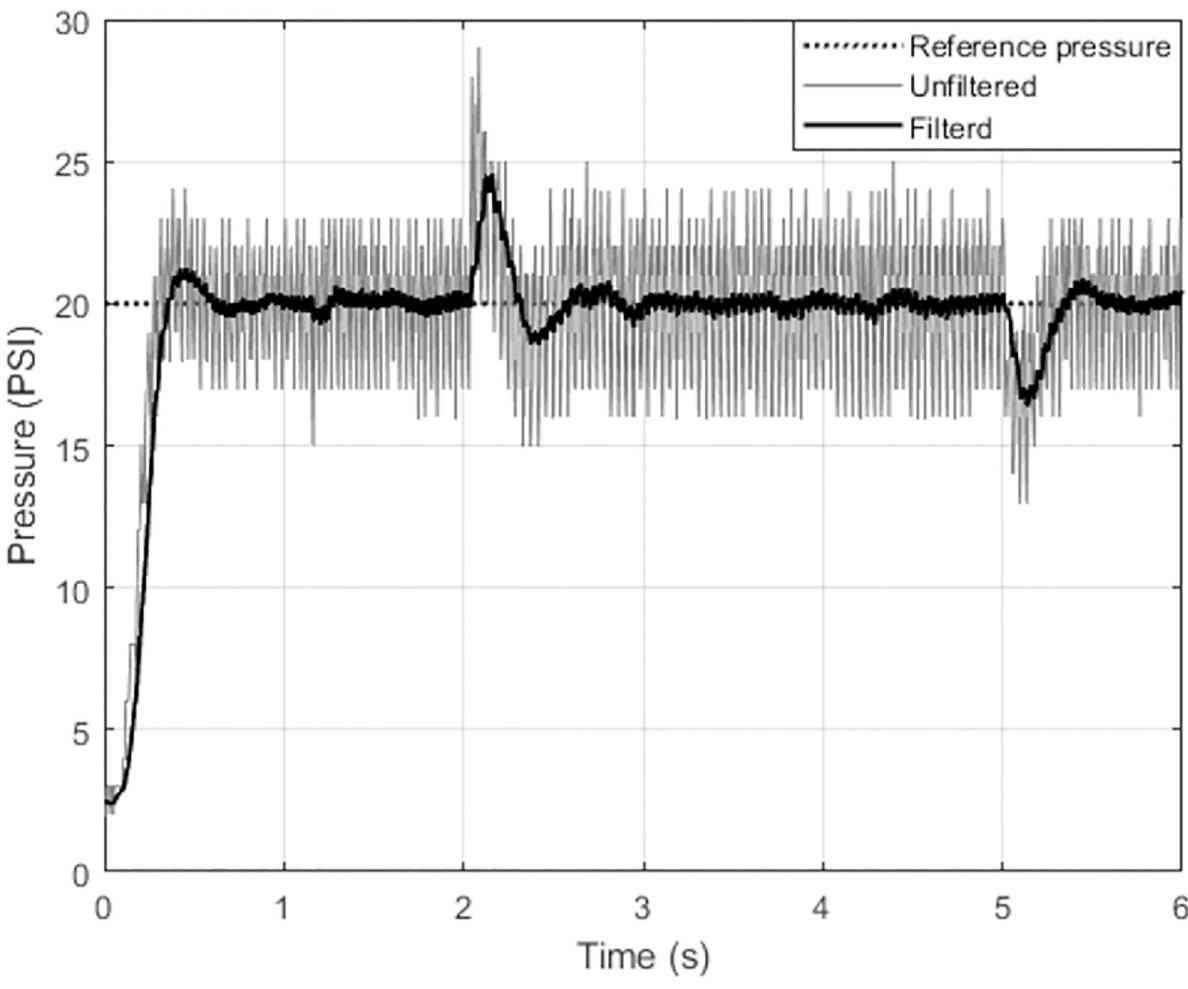
Fig 13. Filtered pressure signal using low-pass filter.